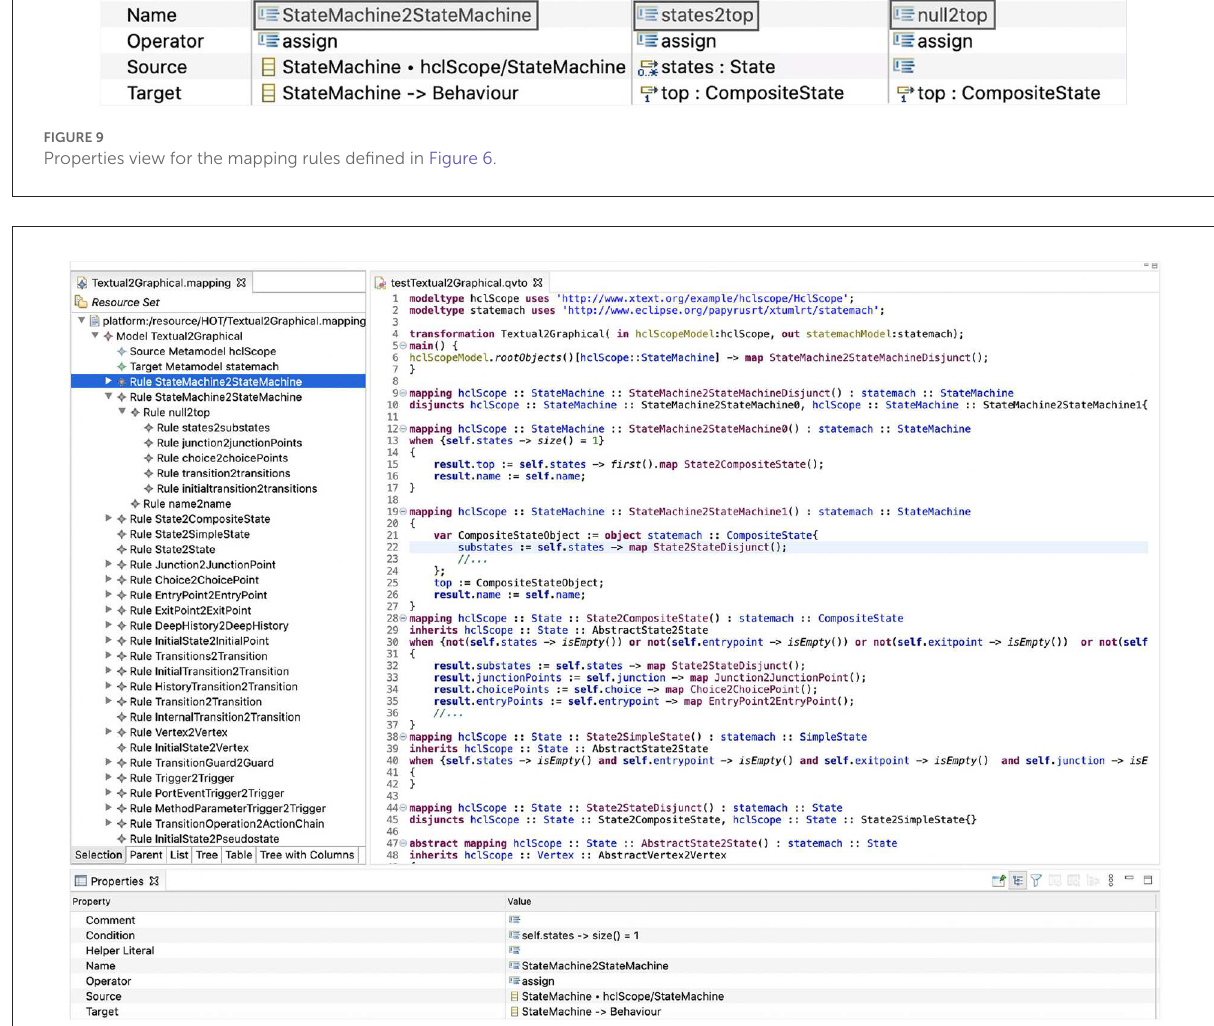
FIGURE10 Textual to graphical mapping model and generated QVTo transformations for UML-RT state